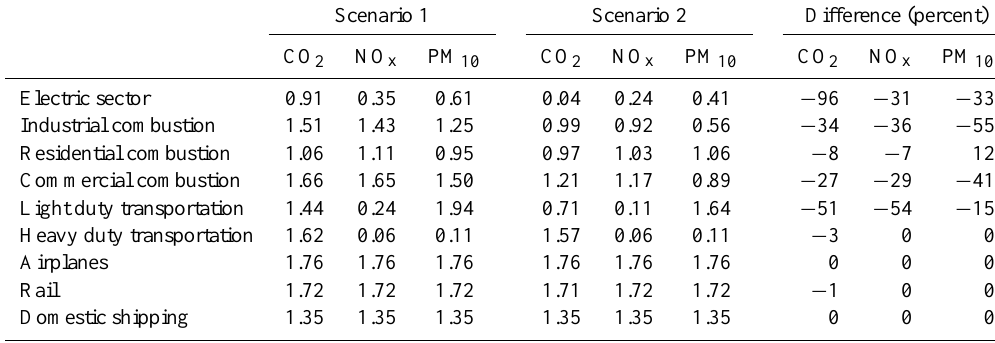
Table 2. EPA MARKAL Region 5 ∗ emissions growth factors, 2005 to 2050, for major energy system emission categories.